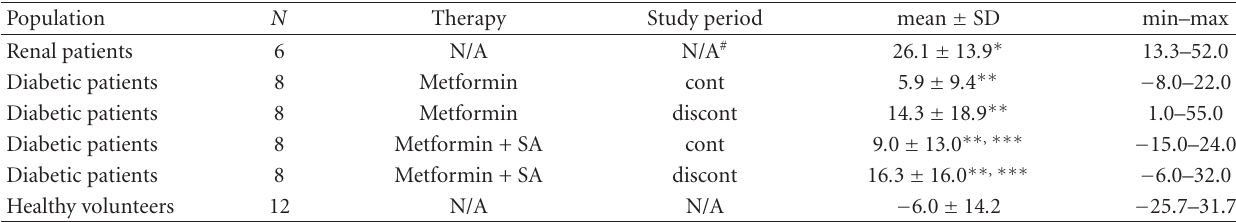
Table 4: Augmentation index.